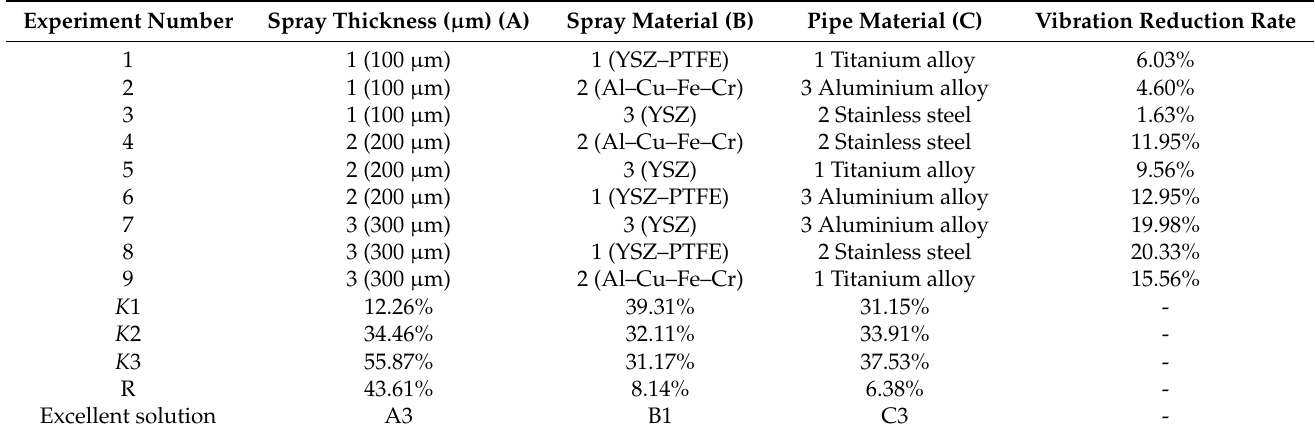
Table 12. Orthogonal experimental results showing the vibration responses of the low-voltage rotor under constant-frequency excitation.